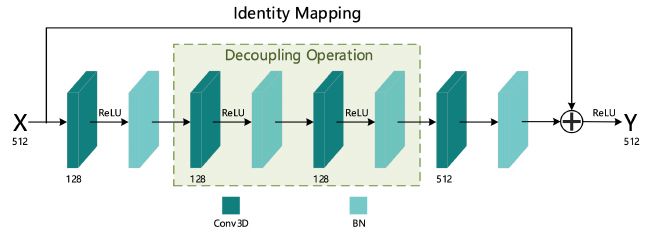
Figure 4. Three-dimensional residual structure.